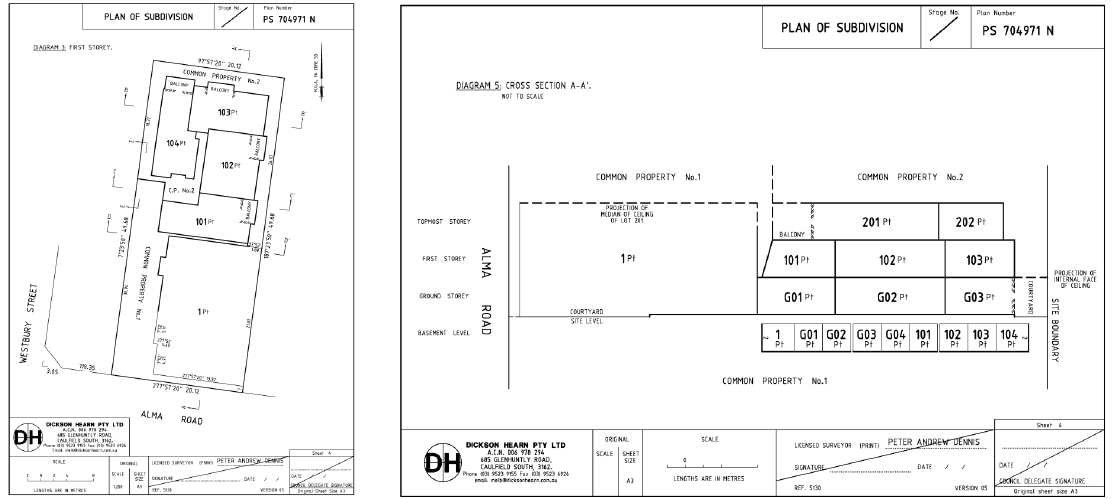
Figure 1. A building subdivision plan in Victoria including floor plans and cross-sections.